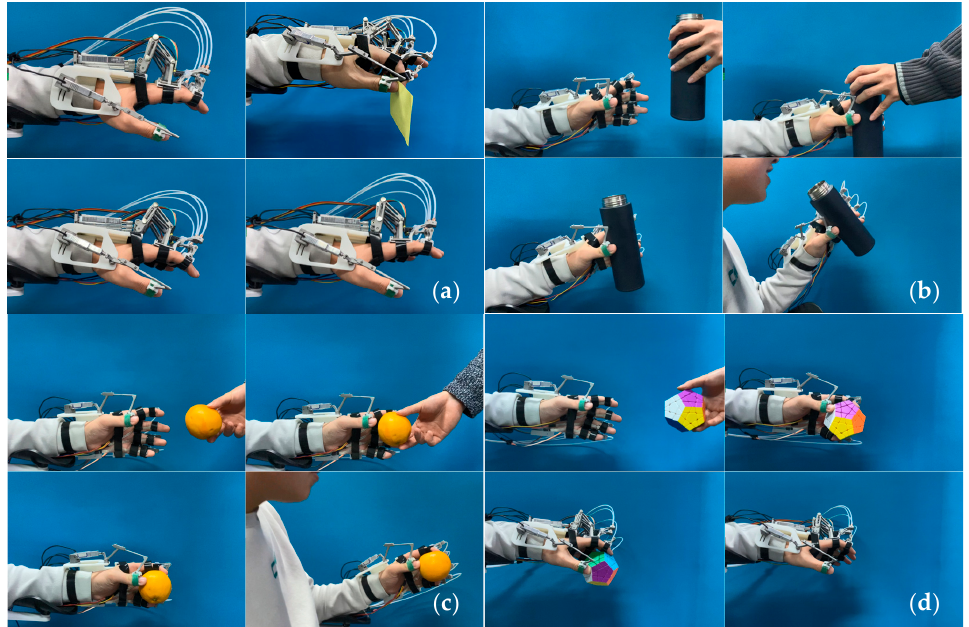
Figure 15. Grasp ability experiment: ( a ) Pinching paper; ( b ) Grasping a cup; ( c ) Picking an orange; ( d ) Handling a Rubik’s cube.